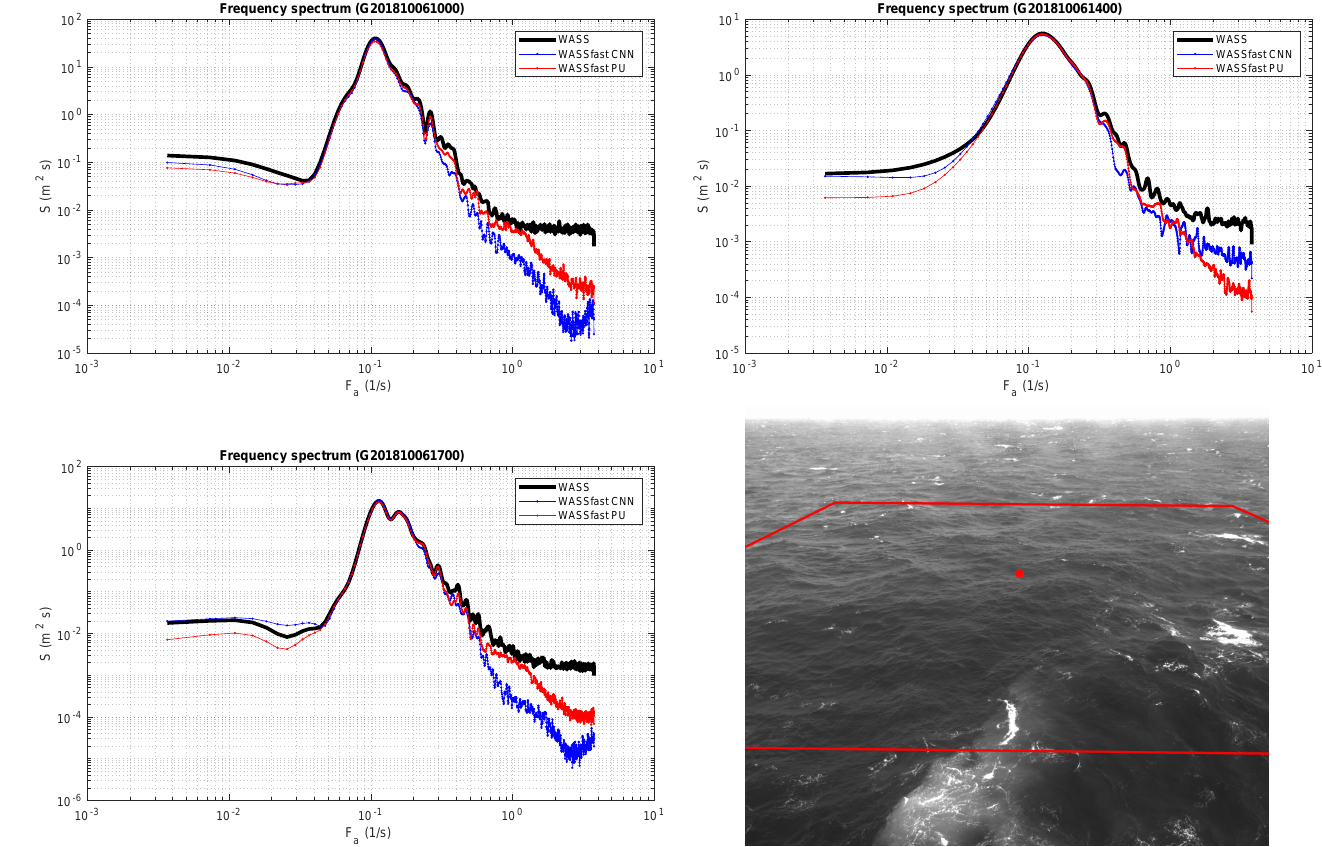
Figure 11. Frequency-spectra comparison between WASS, WASSfast PU, and WASSfast CNN. Bottom - right : The recon- structed area (red polygon) with the grid point used to extract the elevation